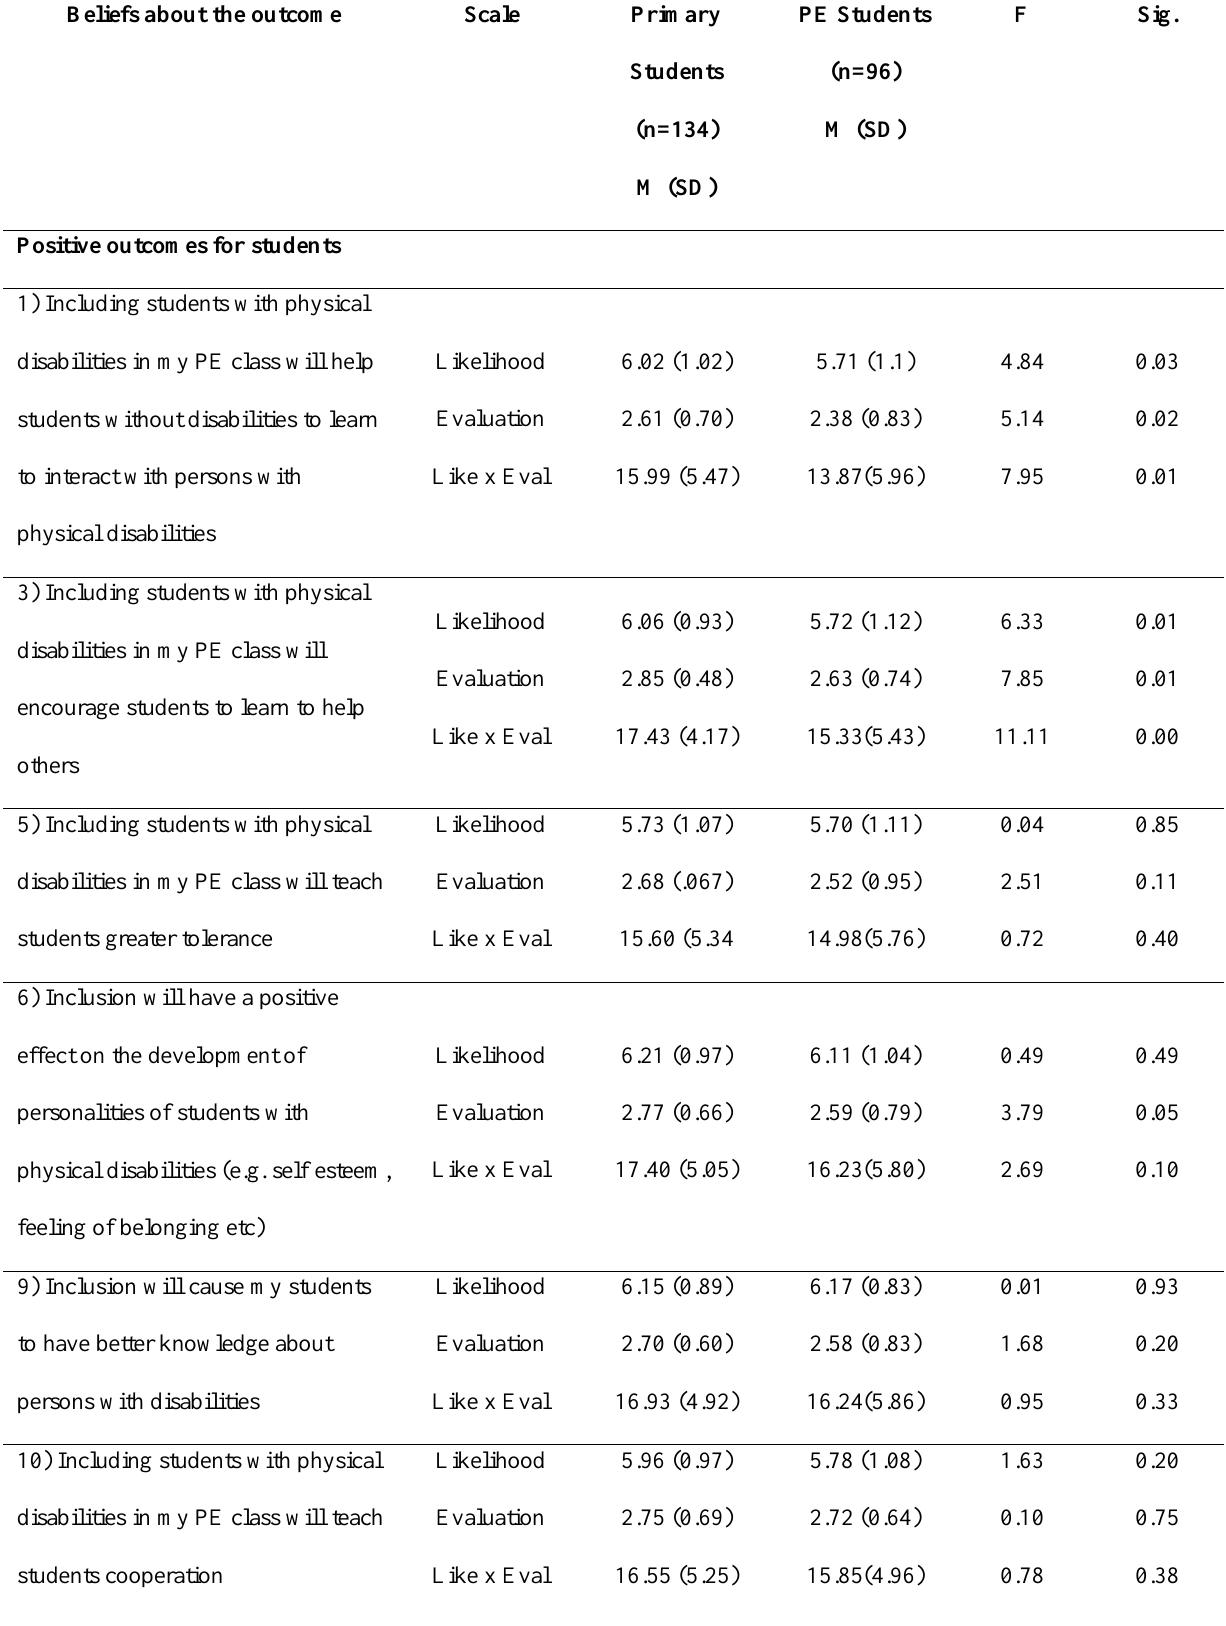
Table 7 Behavioural belief scores including individual belief items Beliefs about the